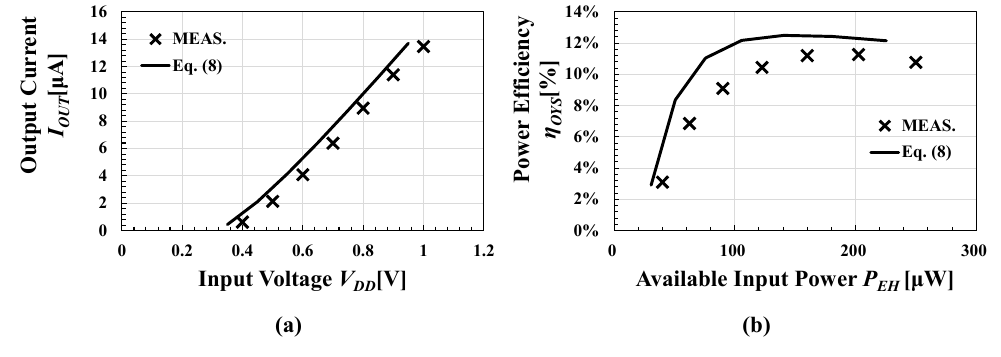
Figure 16. ( a ) I OUT – V DD , ( b ) η SYS – P EH ( f IN = 1 kHz, f CLK = 5 MHz, V OUT = 2 V). (cid:3364)(cid:3364)(cid:3364)(cid:3364)(cid:3364)(cid:3364) – V Figure 16. ( a ) I Figure 16. ( a ) I OUT (cid:3364)(cid:3364)(cid:3364)(cid:3364)(cid:3364)(cid:3364) – V DD , ( b ) η SYS – P EH ( f IN = 1 kHz, f CLK = 5 MHz, V OUT = 2 V). DD , ( b ) η SYS – P EH ( f IN = 1 kHz, f CLK = 5 MHz, V OUT = 2 V). OUT